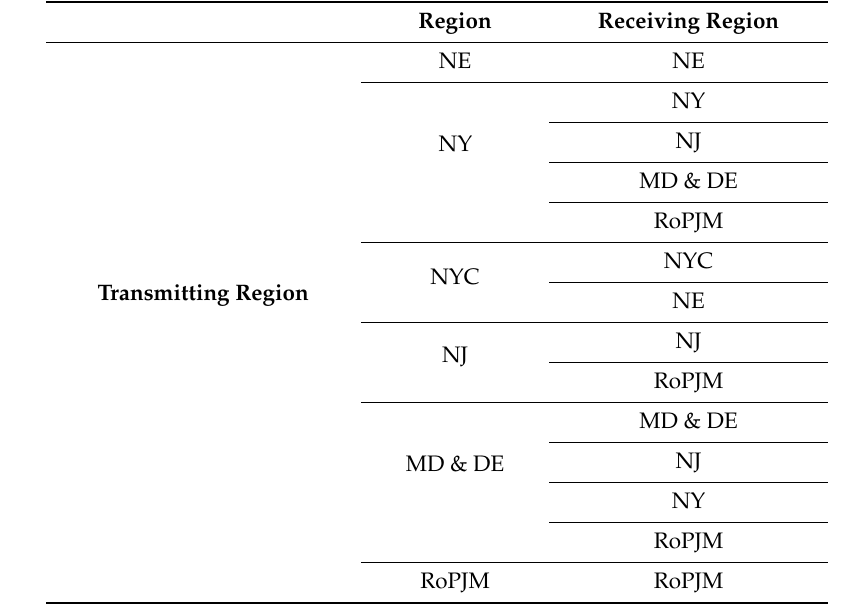
Table A10. Renewables Trading Network (General Electric International, 2014).